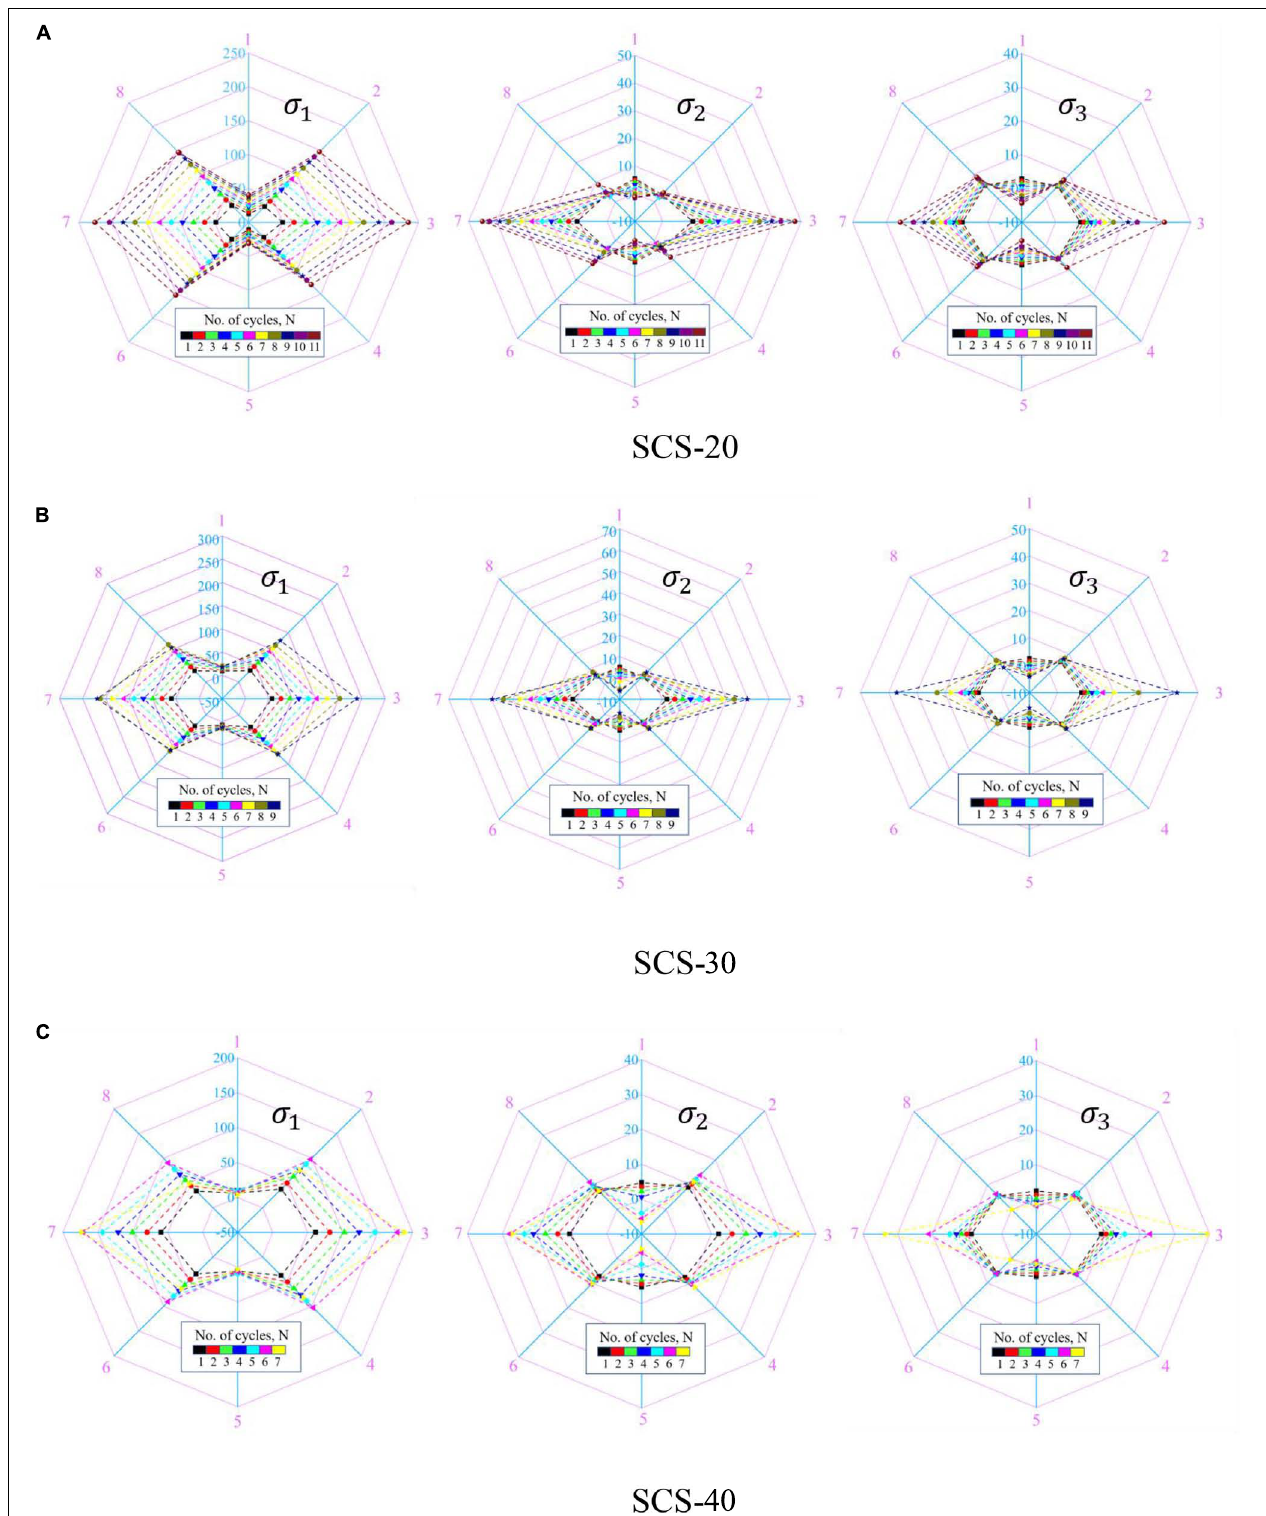
FIGURE 10 | σ 1 , σ 2 , and σ 3 stress fields of (A) SCS-20, (B) SCS-30, and (C) SCS-40 at different cycle numbers (Unit: MPa).